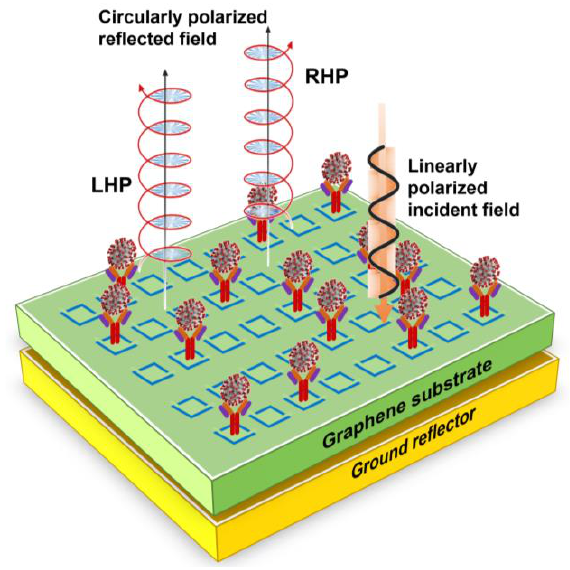
Figure 8. Metasurface sensor based on chiral-localized surface current. A monochromatic linearly polarized light impinges on the pattered surface. This is properly functionalized with antibody or bioreceptor protein able to catch the virus of interest. Depending on the refractive index of the considered analyte–antibody system, the ellipticity of the circularly polarized reflected field changes, providing the detection signal.